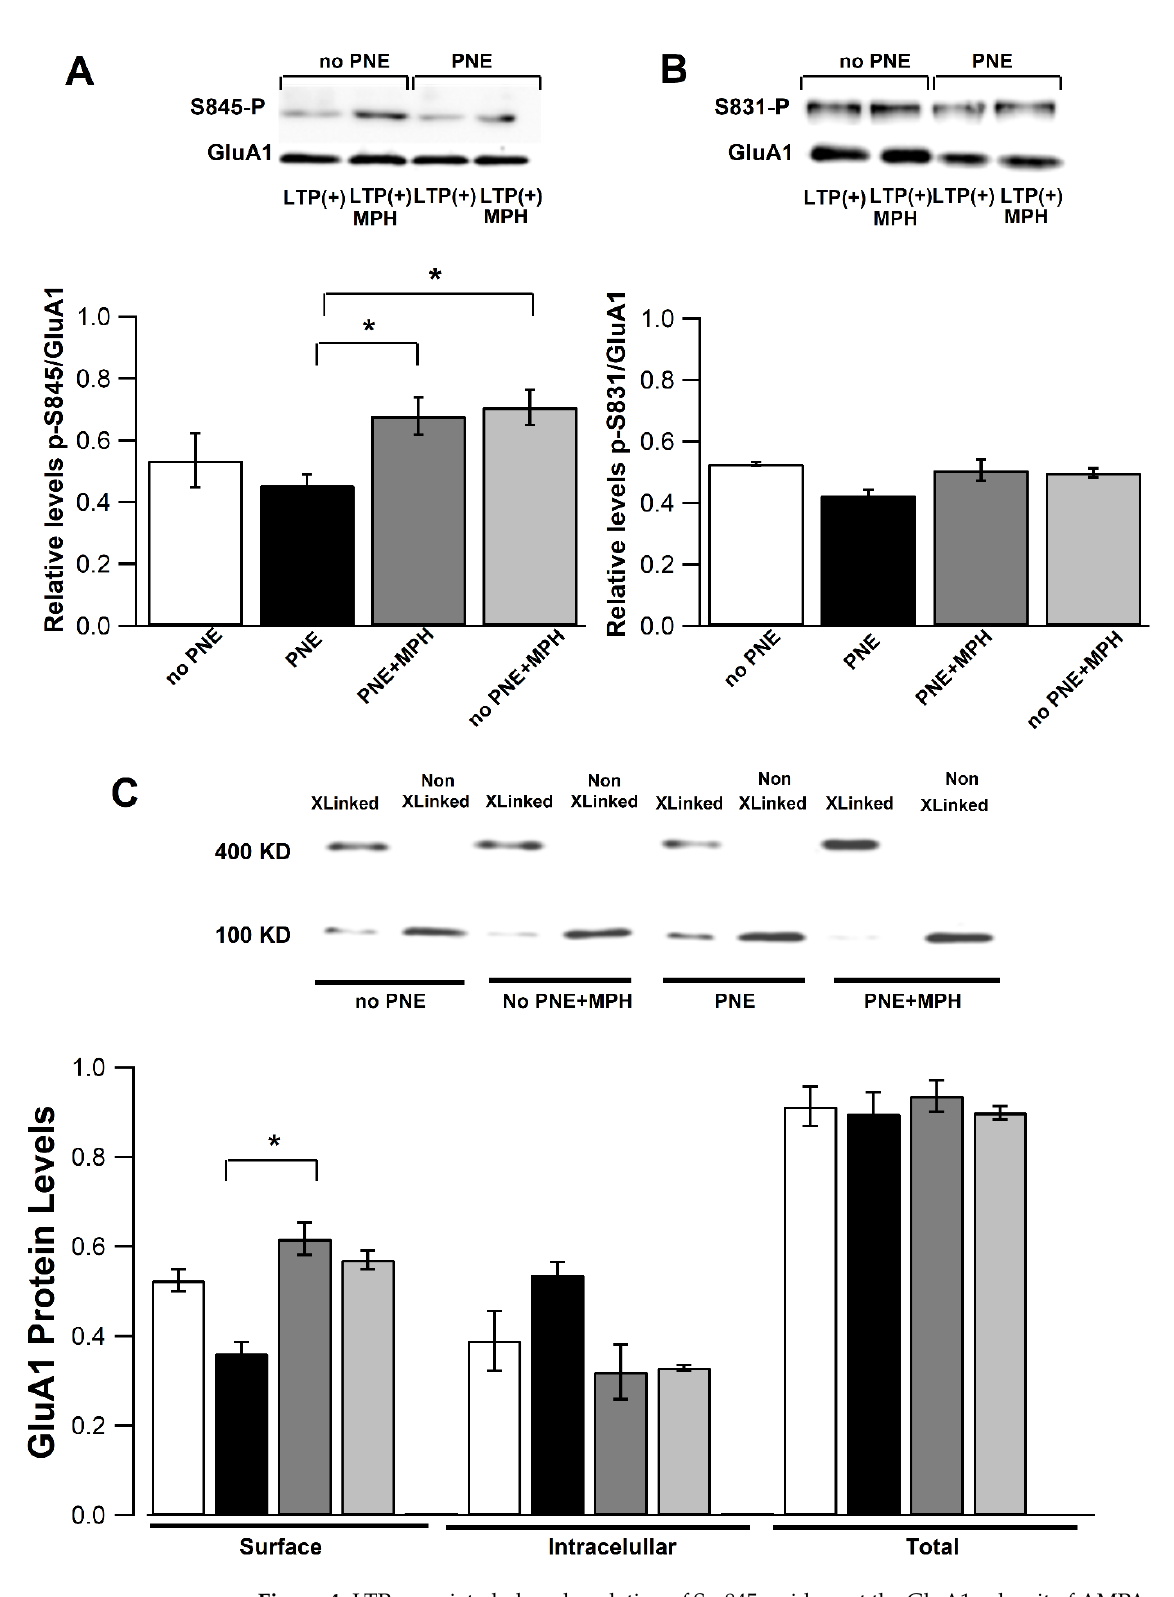
Figure 4. LTP-associated phosphorylation of Ser845 residues at the GluA1 subunit of AMPA receptors and surface fraction of GluA1-containing receptors are decreased in PNE animals and are recovered after MPH administration. ( A ) Western blot for phospho-Ser845 of GluA1 subunit of AMPA receptor in protein extracts of CA1 areas (after LTP induction) from brain slices of no−PNE (lane 1), MPH-treated no−PNE (lane 2), PNE (lane 3), and MPH-treated PNE animals (lane 4). Bar plot: Densitometric quantification of phospho-Ser845-GluA1 reactive bands normalized to the band total